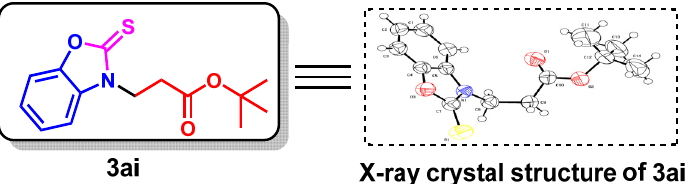
Figure 2. X-ray crystallography of 3ai .